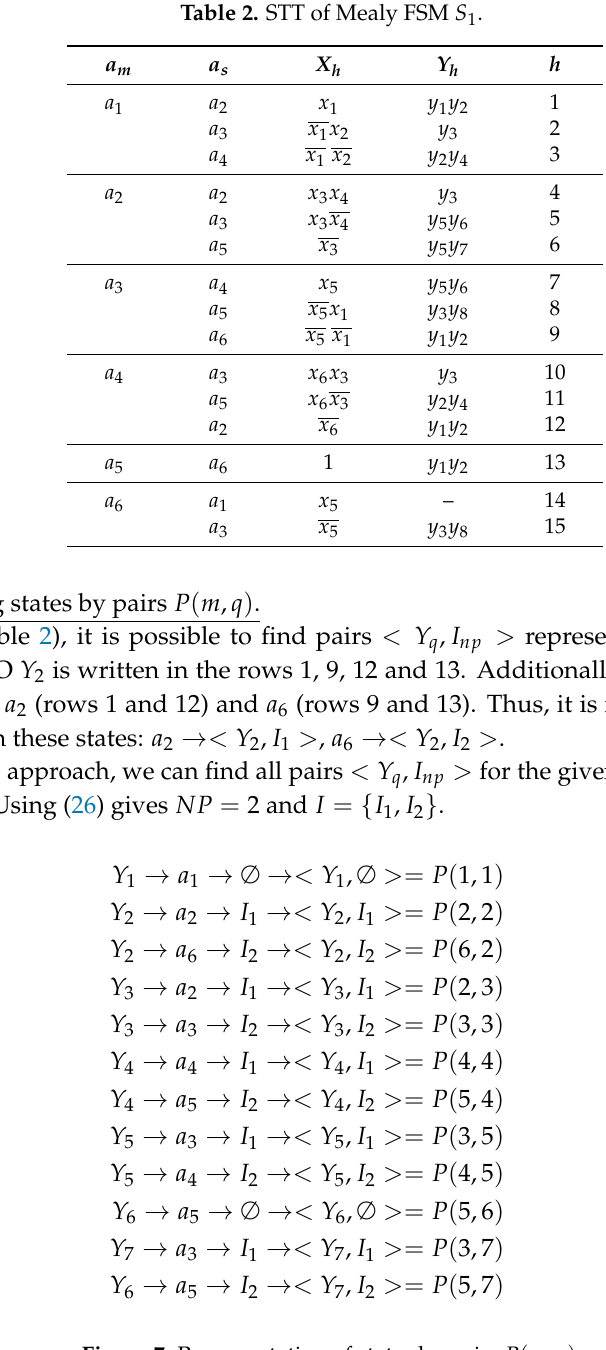
Figure 7. Representation of states by pairs P ( m , q )